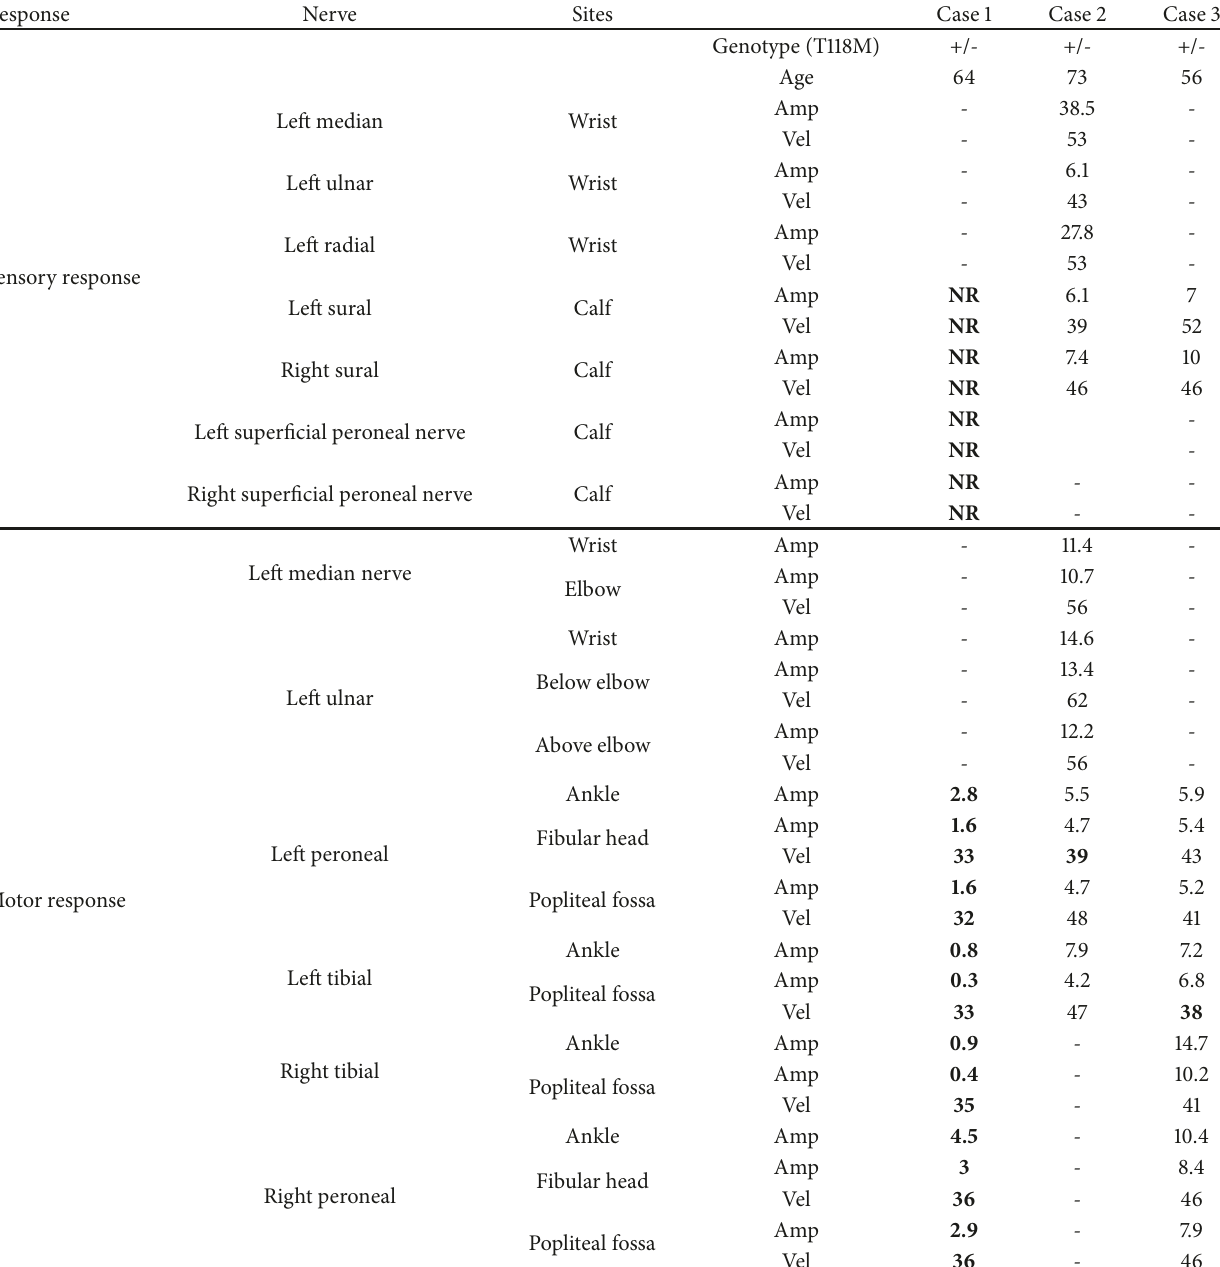
Table 1: Electrophysiological studies of the threecases. Amp:amplitude ( 𝜇 V) and Vel:velocity(m/s). NR: no response.Bold numbersindicate abnormal